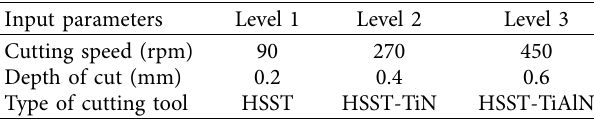
Table 4: Input parameters and their levels.